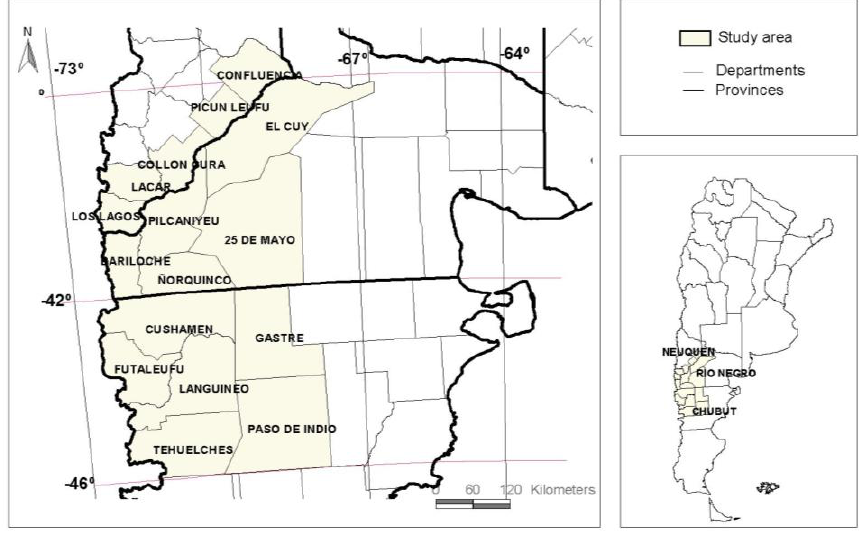
Figure 1. Location of the departments in the northwestern Patagonia region, adapted from